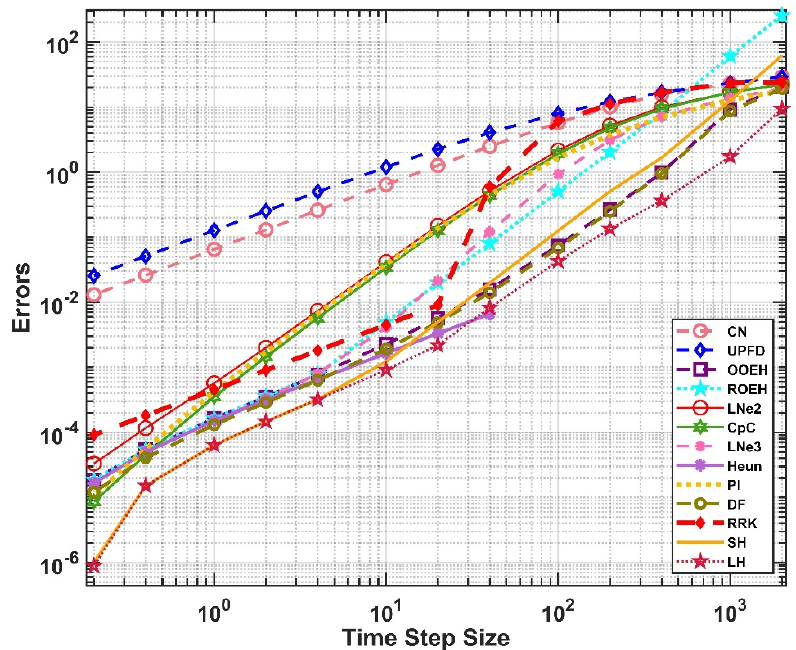
Δ for the equidistant mesh for